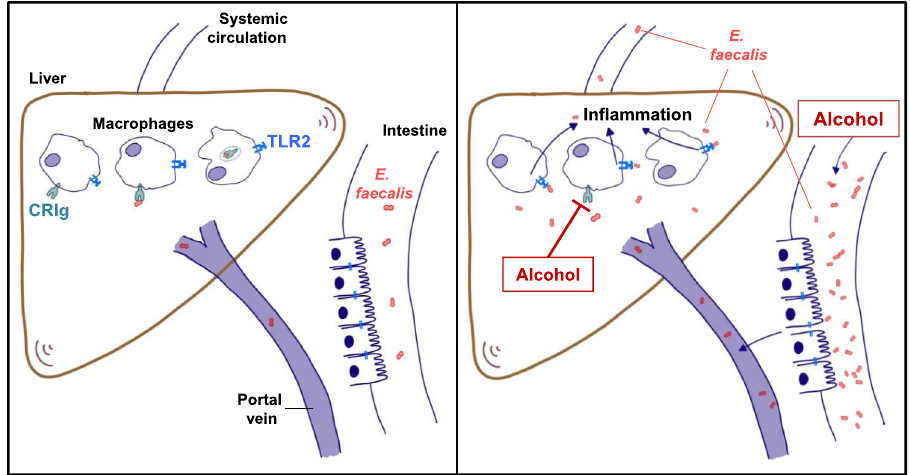
Fig. 6 Alcohol reduces the clearance of pathobionts by Kupffer cells and contributes to liver disease. Left panel: During homeostasis, translocation of pathobionts from the gut to the liver is a rare event. Translocated E. faecalis are cleared and phagocytosed by CRIg on Kupffer cells. Right panel: